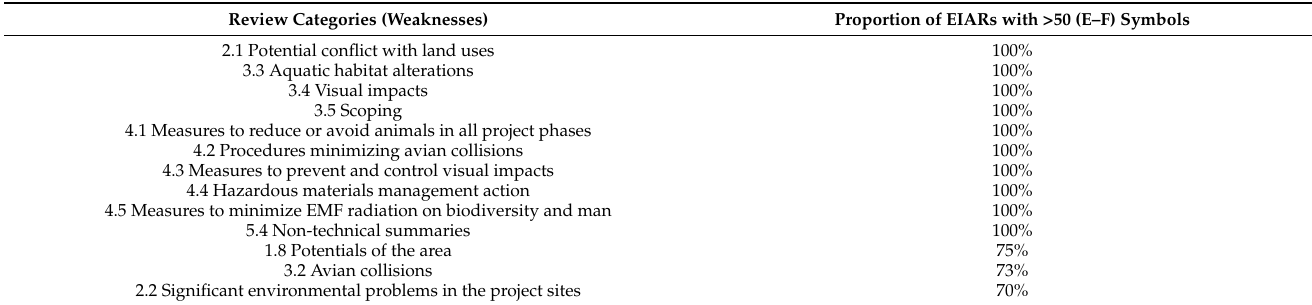
Table 11. Areas of weaknesses (E–F) in the EIARs assessed for their quality.